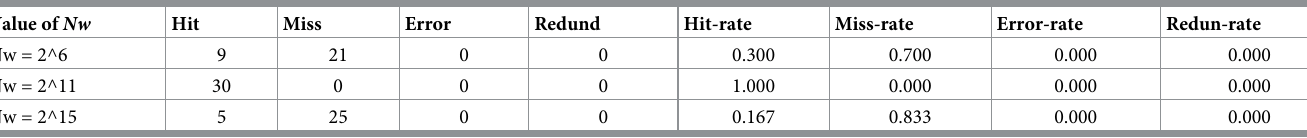
Table 3. The analyses on MCPs detection as Nw = 2^6, 2^11, and 2^15 in the TST-based FWS framework.